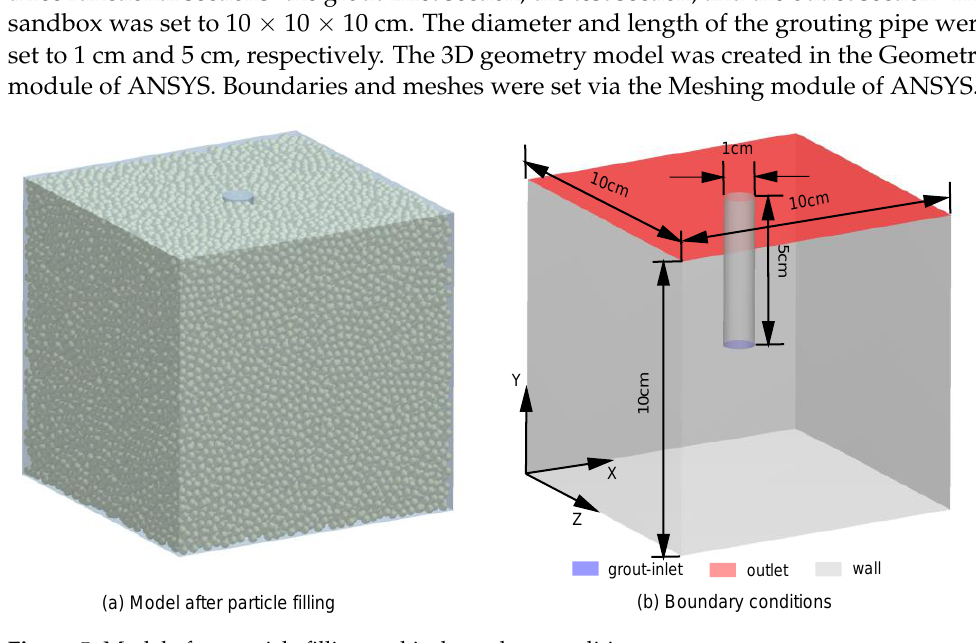
Figure 5. Model after particle filling and its boundary conditions.